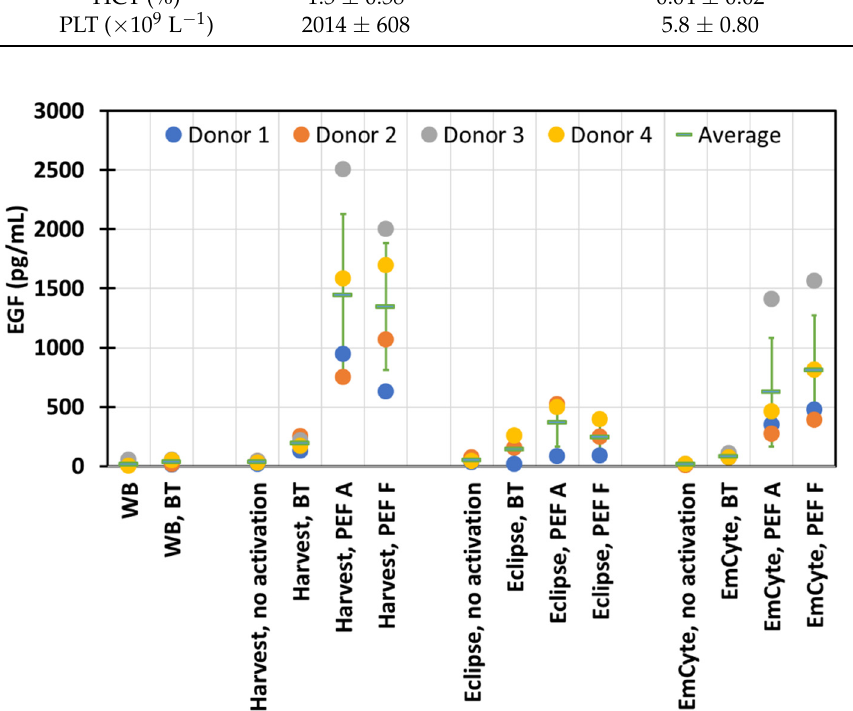
Figure 1. Representative voltage and current waveforms for pulsed electric field conditions ( a ) peak voltage ~4.3 kV and pulse duration 2 µs (PEF A) and ( b ) peak voltage ~3.5 kV and pulse duration 5 µs (PEF F). Electric stimulation of PRP used a single electric pulse.